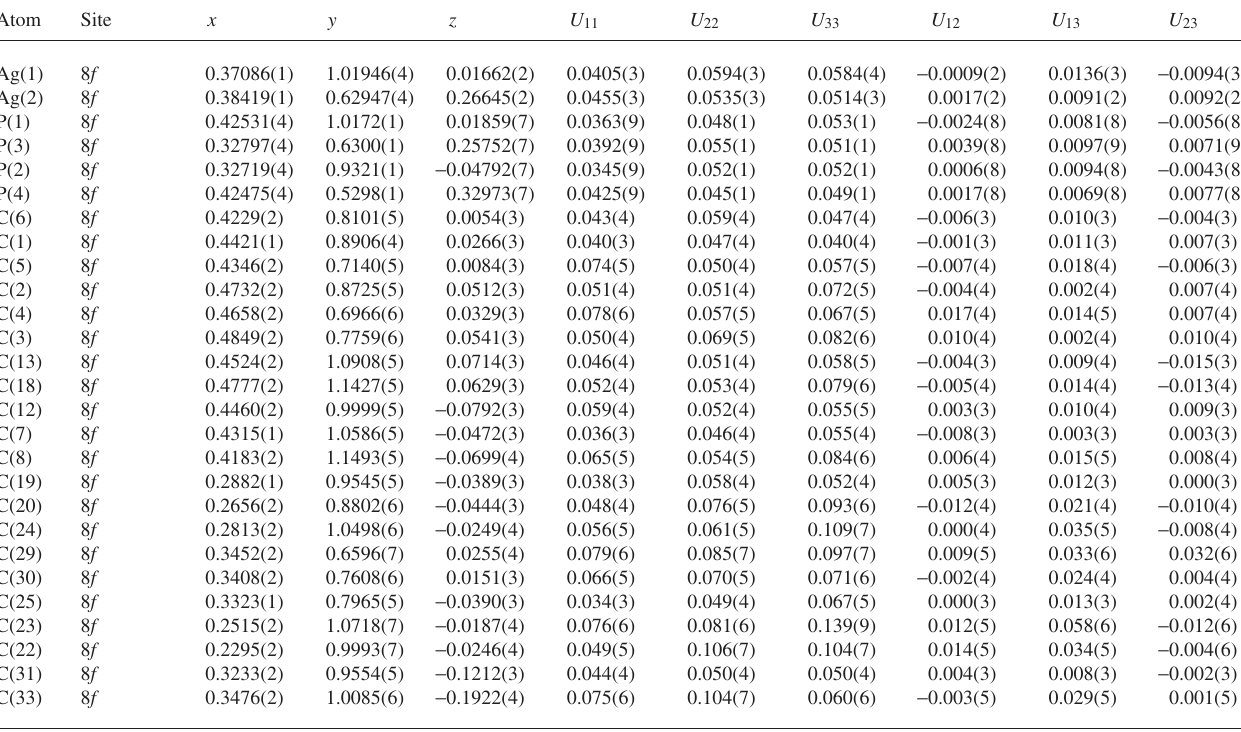
Table 3. Atomic coordinates and displacement parameters (in Å 2 ) .